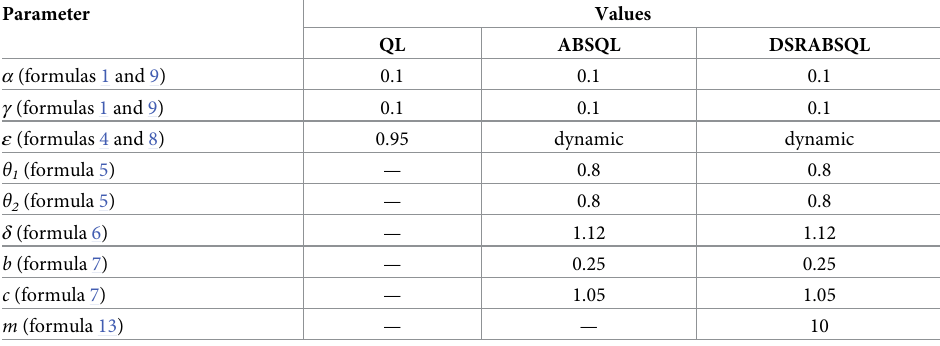
Table 1. Simulation parameters for the QL, ABSQL and DSRABSQL